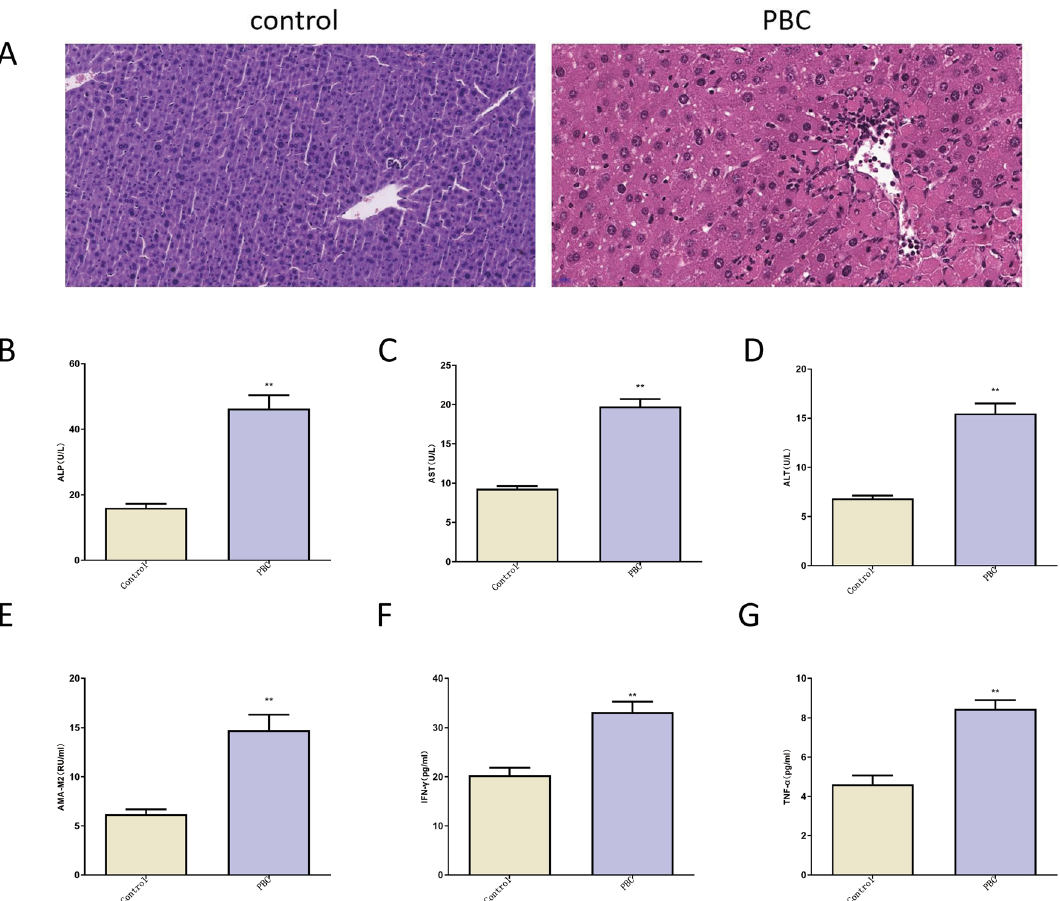
Figure 3. Histopathological and serum biochemical index analysis of PBC mice. ( A ) HE staining examination of liver tissues obtained from PBC mice (n = 10) and wild type mice (n = 10). ( B – G ) Levels of ALP, AST, ALT, AMA-M2, IFN-γ, and TNF-α in serum samples of PBC mice (n = 10) and wild type mice (n = 10) were measured by corresponding kits and ELISA